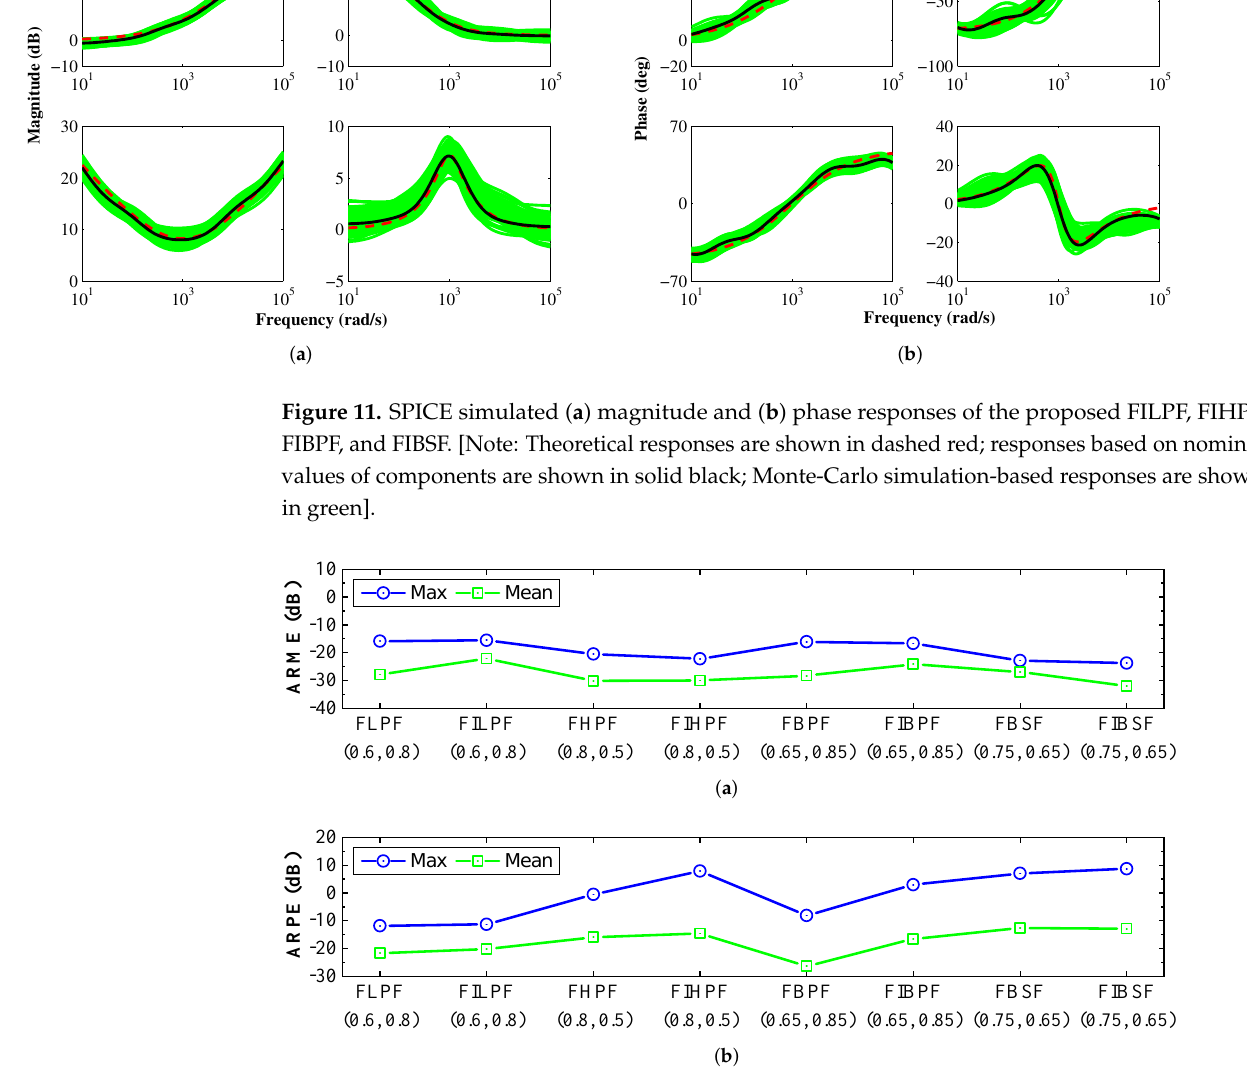
Figure 12. Broken line plots of the ( a ) ARME and ( b ) ARPE responses for the SPICE simulated proposed FLPF, FHPF, FBPF, FBSF, and their inverse counterparts realized using the nominal values of